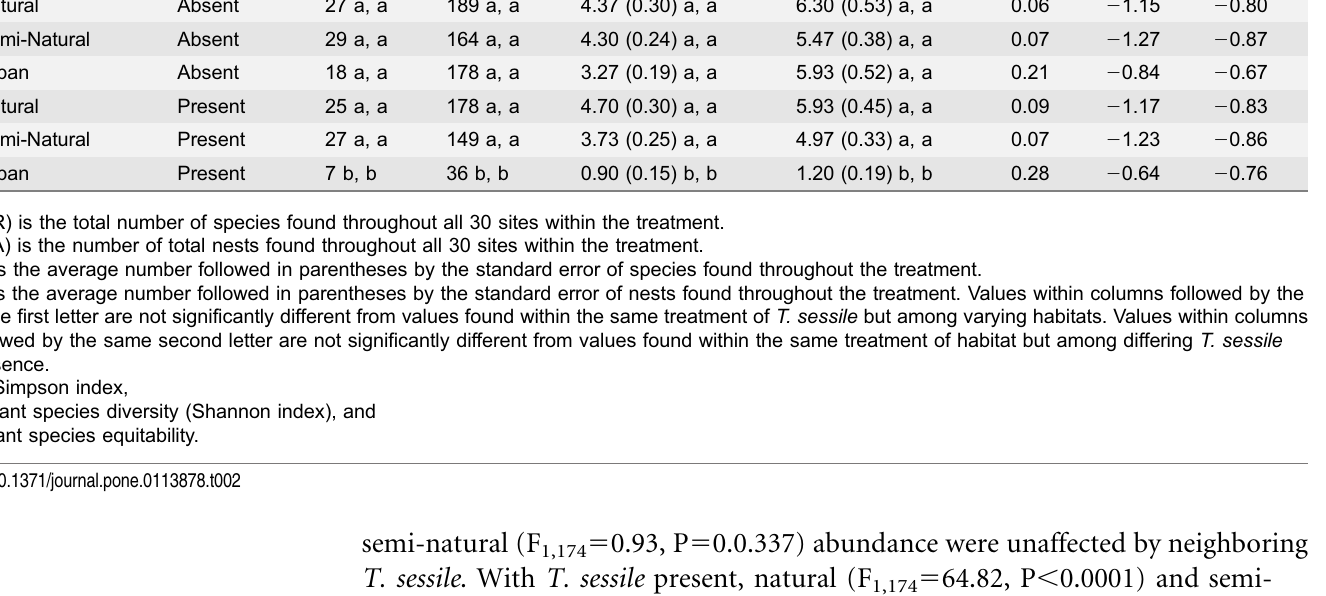
5 0.93, P 5 0.0.337) abundance were unaffected by neighboring semi-natural (F 1,174 5 64.82, P , 0.0001) and semi- T. sessile . With T. sessile present, natural (F 1,174 5 41.05, P , 0.0001) habitats correlated significant decreases in total natural (F 1,174 abundance when converted to urban habitat. A total of 178 nests within urban plots without odorous house ants decreased to 36 nests with neighboring T. sessile ,